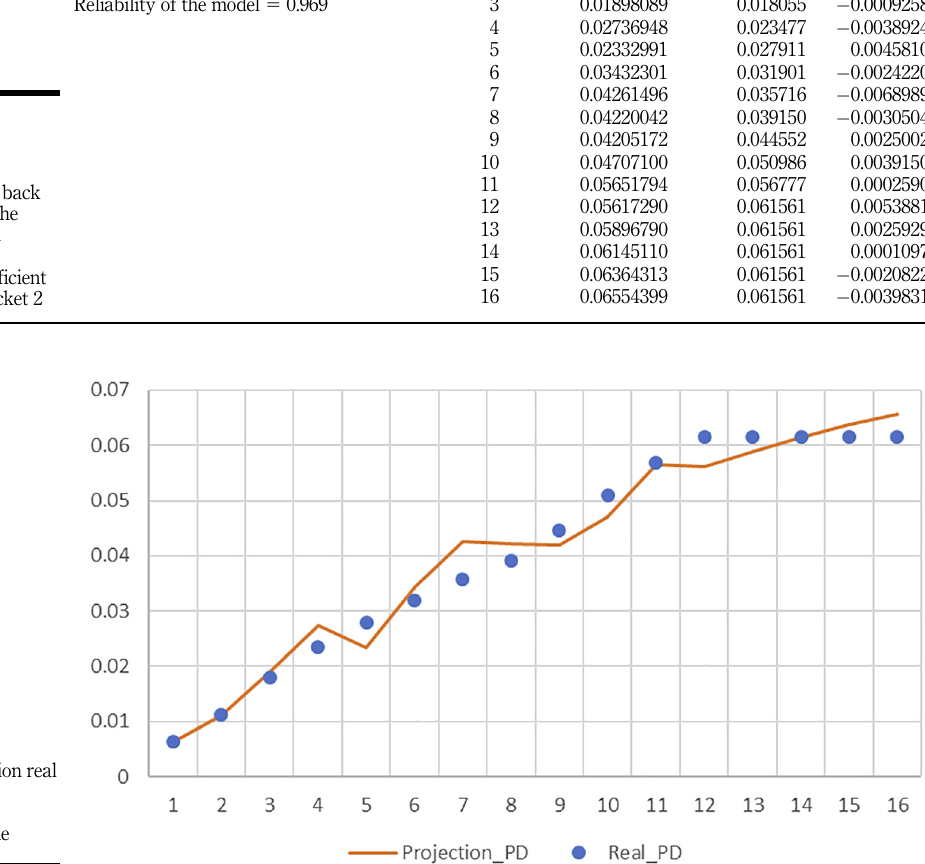
Figure 2. The PD projection real PD patterns throughout the observation